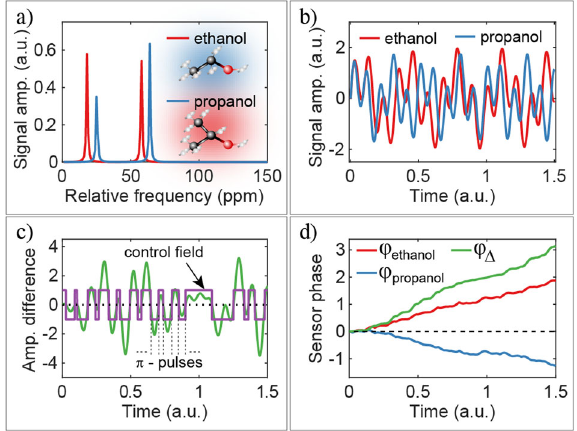
Fig. 3 Optimal frequency discrimination of complex signals. a , b Calculated magnetic fi eld experienced by the NV center exposed to a solution of ethanol (red) or propanol (blue) in frequency ( a ) and time ( b ) domains, where a π /2 pulse is applied to the thermally polarized sample at zero time. c Calculated optimal control sequence of π -pulses applied to the NV sensor (purple) overlayed on the signal difference (green). d Sensor phase accumulation in presence of ethanol (red), propanol (blue), and the phase difference (green), showing quadratic scaling at short